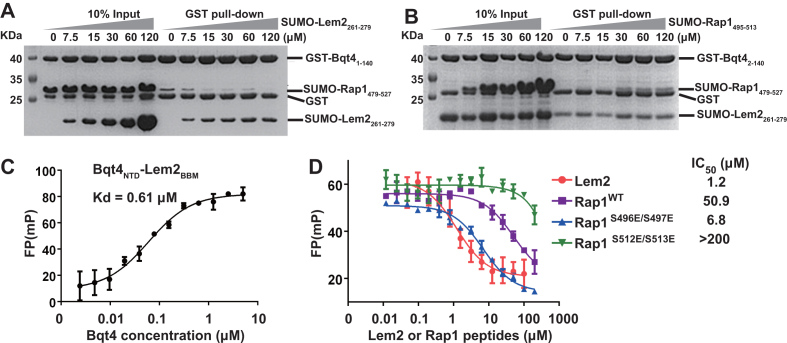
Rap1 and Lem2 bind Bqt4 competitively. (A) In vitro GST pull-down assays examining interactions between GST-Bqt4NTD and SUMO-Rap1479–527 in the presence of different concentrations of Lem2261–279. 15μM GST-Bqt4NTD and 20μM SUMO-Rap1479–527 were incubated for 30 minutes and then titrated with SUMO-Lem2261–279 from 7.5 to 120 μM. 15 μM SUMO-Lem2261–279 can effectively dissociate SUMO-Rap1479–527 from Bqt4NTD. (B) In vitro GST pull-down assays examining interactions between GST-Bqt4NTD and SUMO-Lem2261–279 in the presence of different concentrations of Rap1479–527. 15μM GST-Bqt4NTD and 20μM SUMO-Lem2261–279 were incubated for 30 minutes and then titrated with SUMO-Rap1479–527 from 7.5 to 120 μM. Even the highest concentration of Rap1479–527 cannot dissociate Lem2BBM from Bqt4NTD. (C) FP assays showed that fluorescent FITC-labeled Lem2BBM bound Bqt4NTD. Each point was represented as mean ± s.d. (n = 3). (D) Competitive FP binding curves of Lem2, Rap1WT, Rap1S512E/S513E, and Rap1S496E/S497E binding to the pre-formed fluorescent Bqt4NTD-Lem2BBM complex. The IC50 value was determined by nonlinear regression fitting of the competition curves. Each point was represented as mean ± s.d. (n = 3).